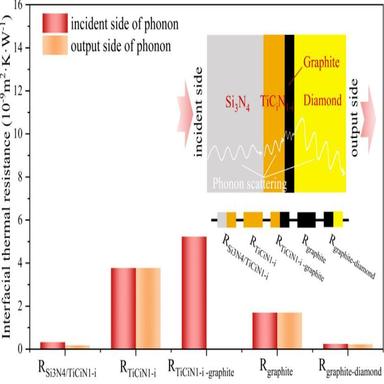
Comparison of interfacial thermal resistance of the composites.